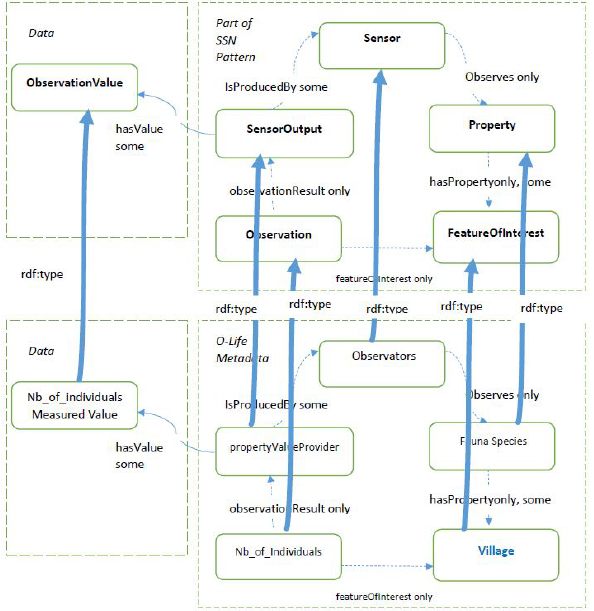
Figure 11. Running example: SSN mapping on the geographic